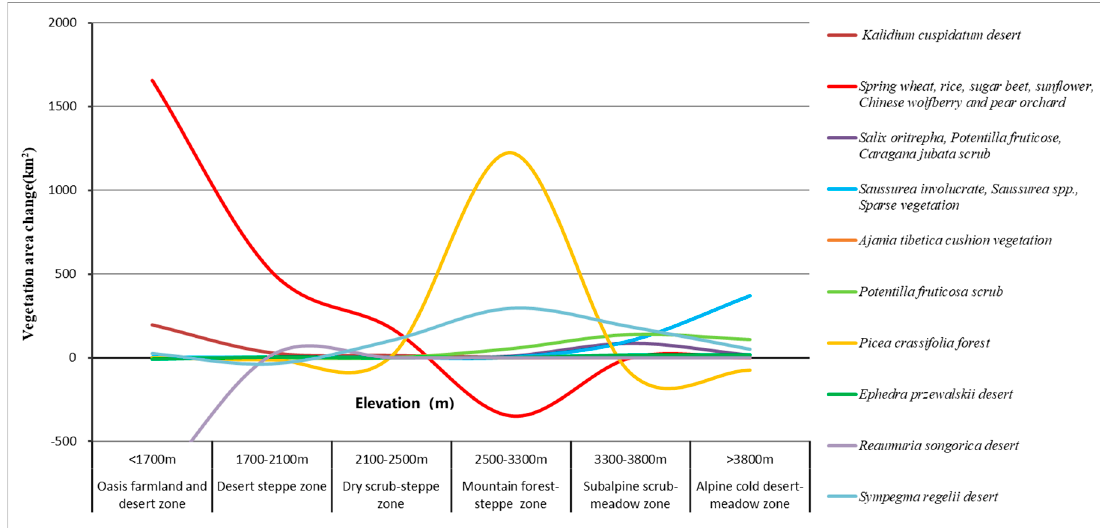
Figure 5. Surface area change of 10 typical plant species with respect to